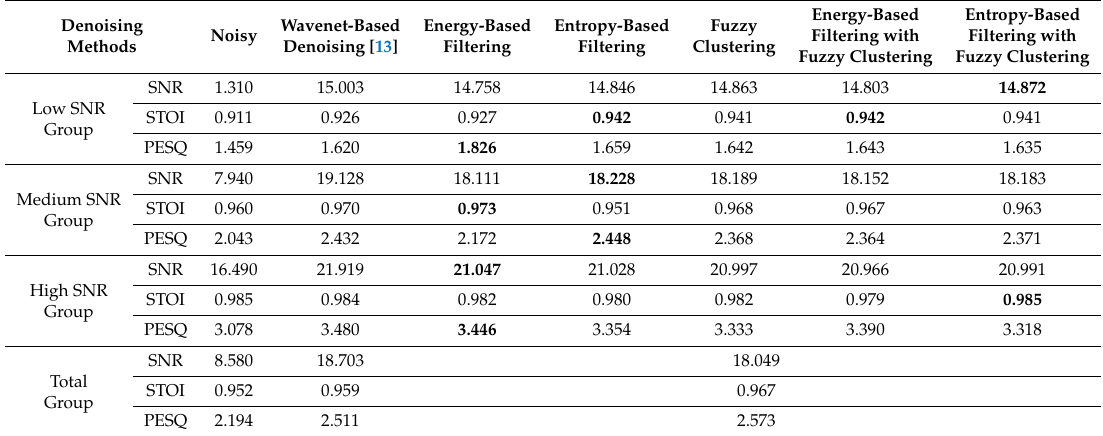
Table 5. The comparison of denoising performance only for the speech